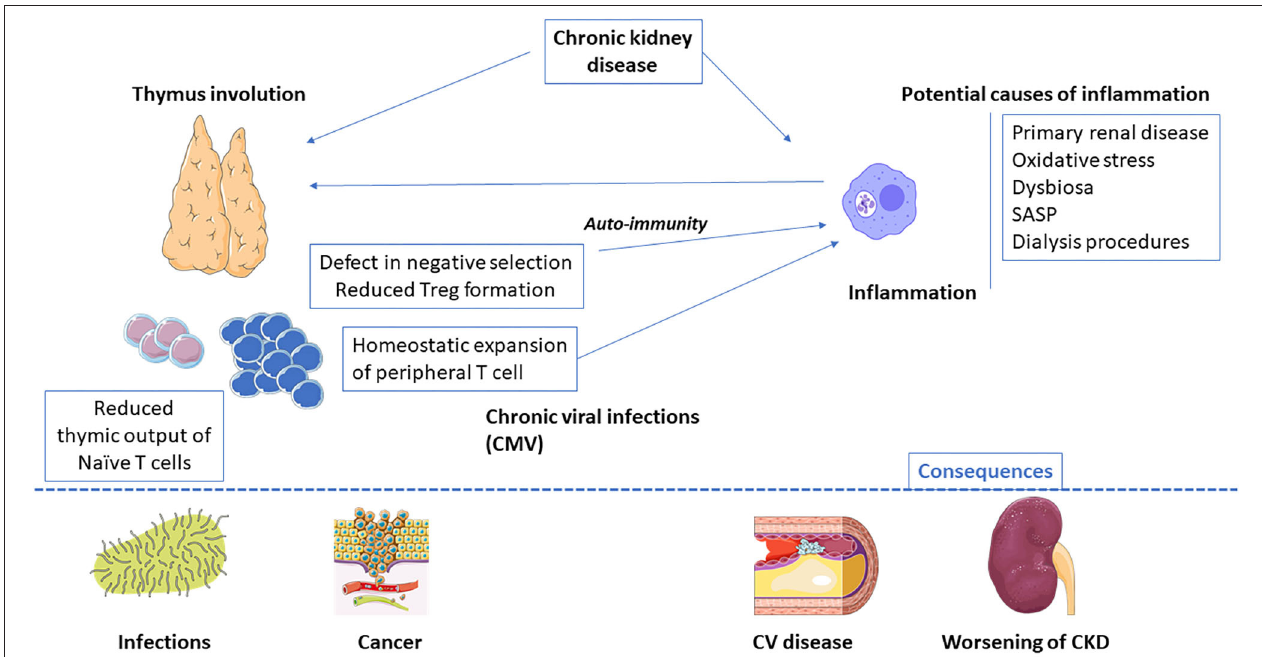
FIGURE 1 | End-stage renal disease-related inflammaging: main causes and potential consequences. CMV, Cytomegalovirus; SASP, senescence-associated secretory